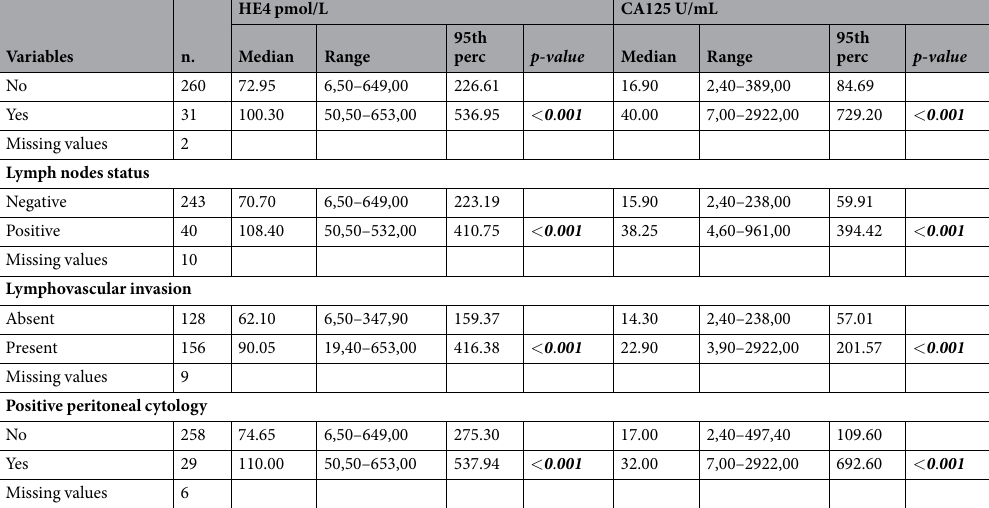
Table 1. Preoperative sCA125 and sHE4 levels in all 293 EC patients divided according to clinicopathological features p-values were computed using non-parametric Wilcoxon-Mann-Whitney or Kruskal-Wallis test. In bold p-values < 0 . 05 . Missing values are not considered in the test procedure. BMI = Body Mass Index; HRT = Hormone Replacement Therapy.